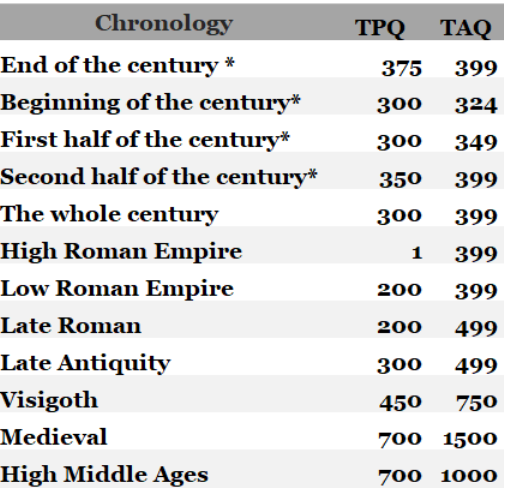
Figure 7. Fork table and its chronological correspondence. (*) The numbers with an asterisk indicate that this is an example; we have considered chronological forks from the 4th century for the examples. We apply the same criteria for the rest of the centuries Own